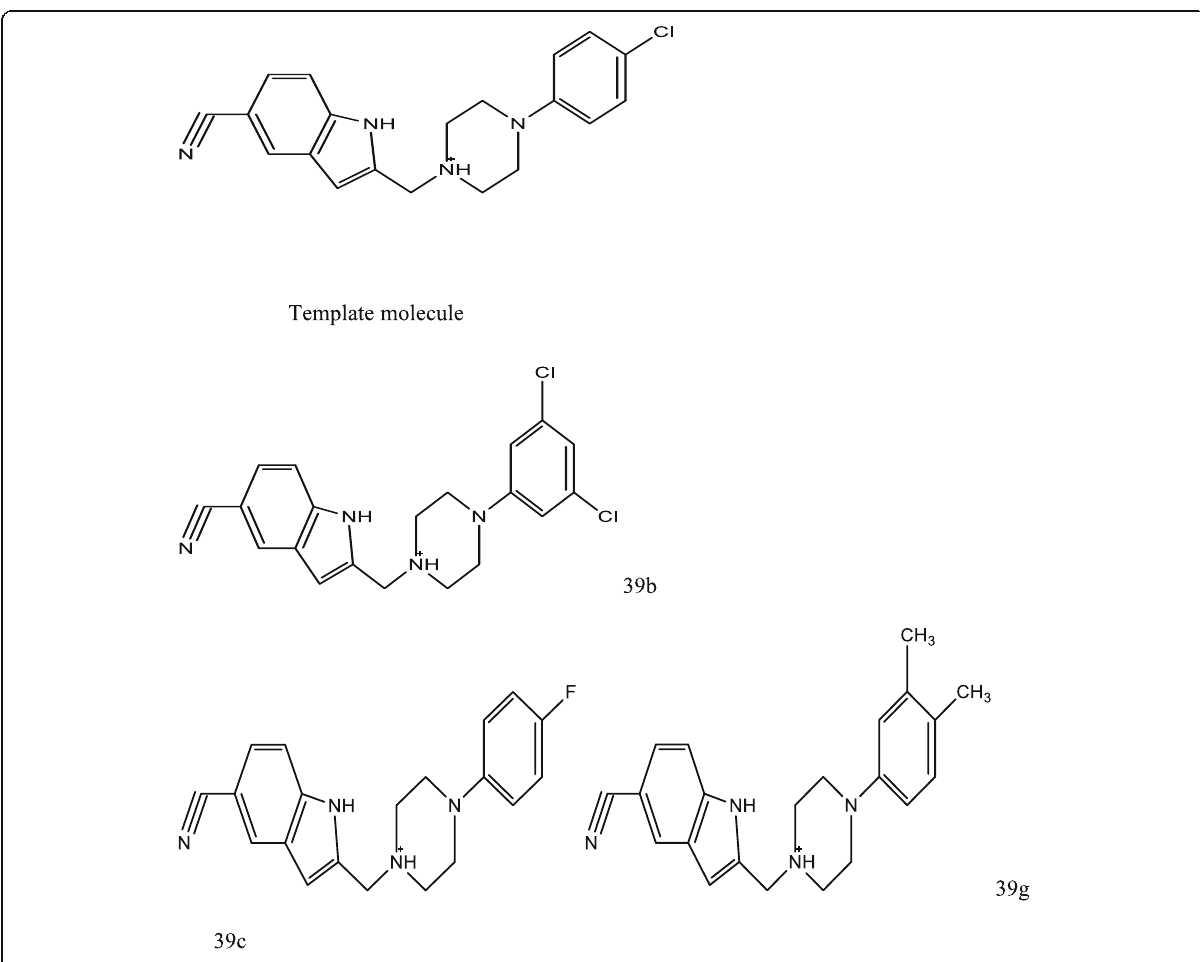
Fig. 1 2D structure of template molecule and some designed inhibitors (39b, 39c, and